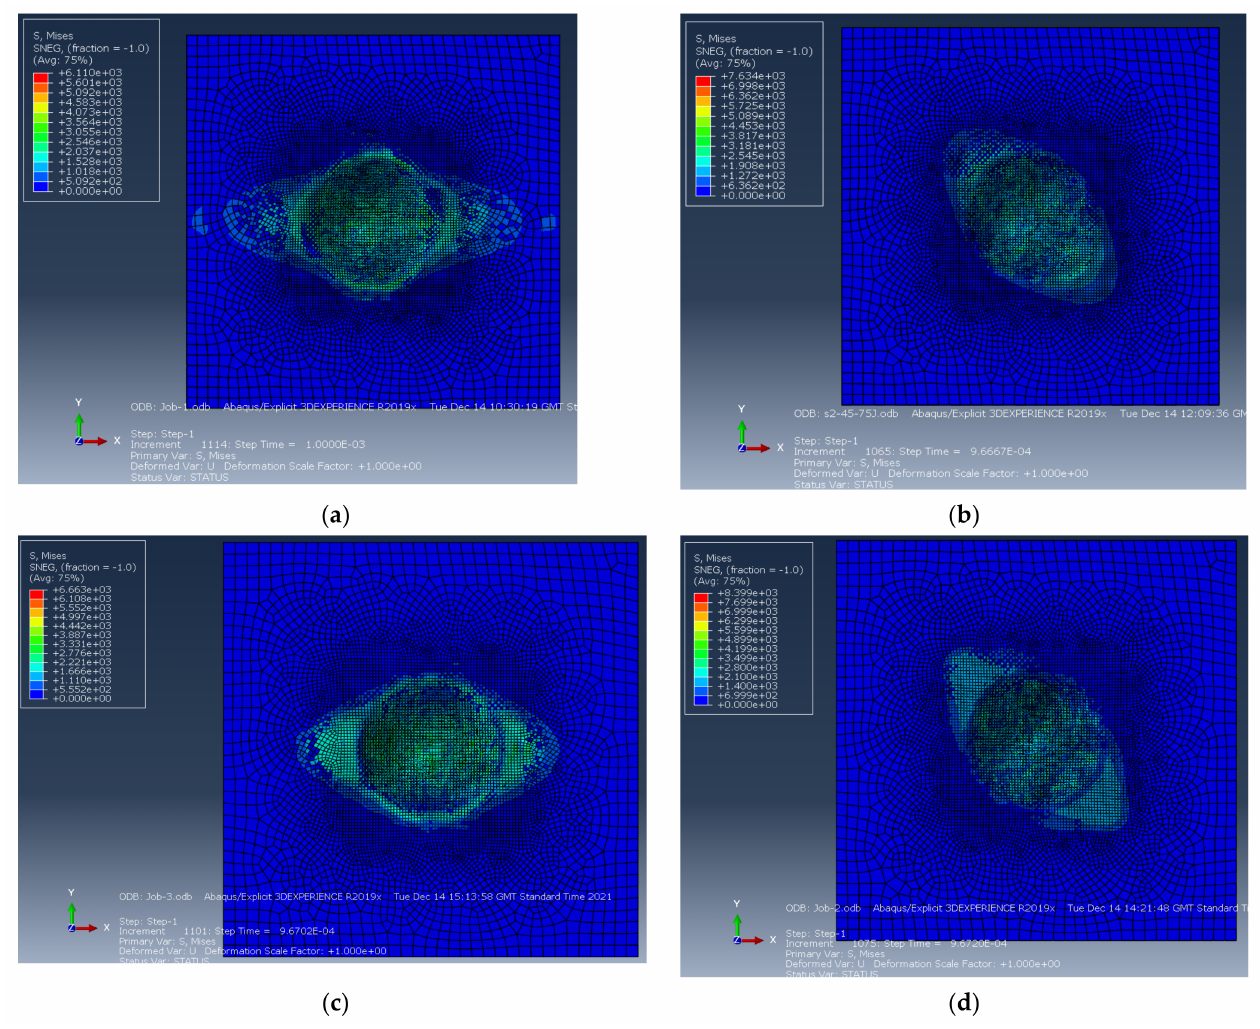
Figure 14. Numerical prediction of delamination damage at the top surface of ( a ) [ 0 ] ( b ) [+ 45/ − 45 ] ( c ) [ 0/90/90/0 ] , and ( d ) [ 0/90/ + 45/ − 45 ] 16 s 8 s